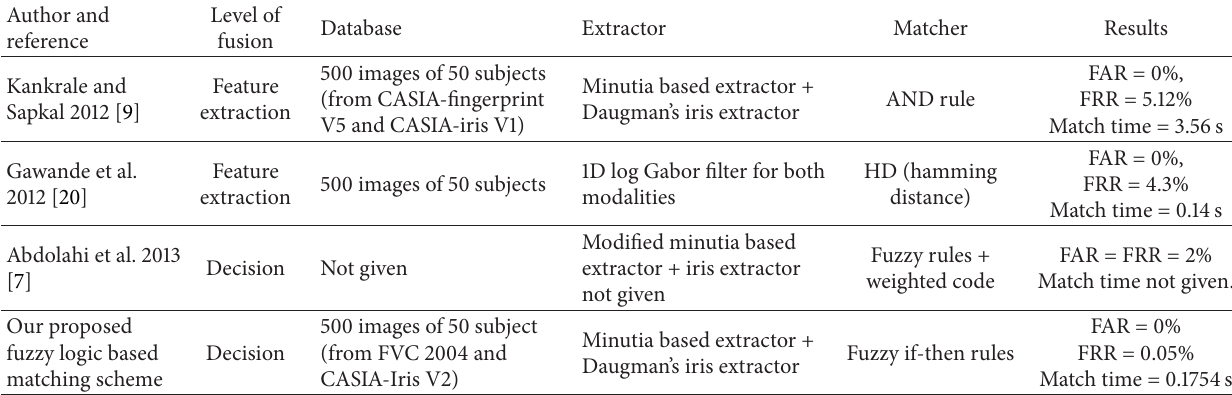
Table 10: Performance comparison with related